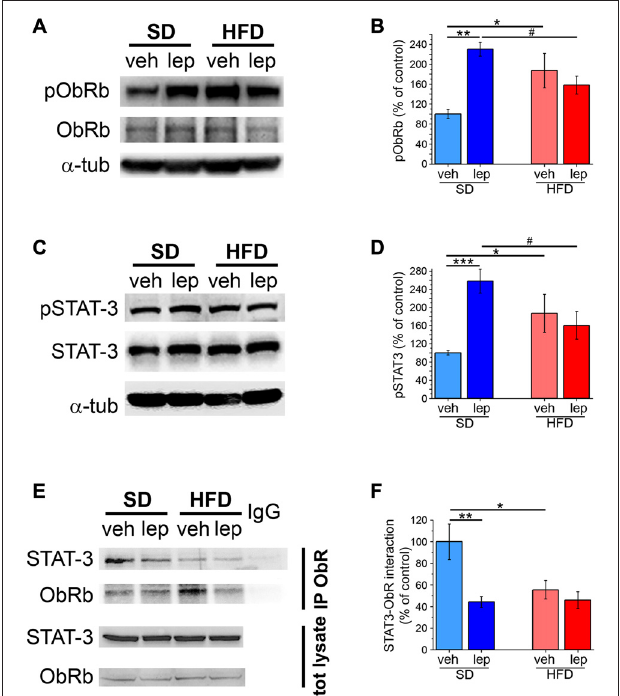
FIGURE 4 | Activation of ObRb and STAT-3 is impaired in HFD mice. (A) Representative images showing immunoblottings for pObRb, ObRb and α -tubulin. (B) Quantification of pObRb activation (SD-veh n = 4, SD-lep n = 4, HFD-veh n = 4, HFD-lep n = 4; ANOVA-2, diet × treatment interaction, p = 0.004, followed by Bonferroni post hoc test, SD-lep vs. SD-veh, ∗∗ p = 0.002, SD-veh vs. HFD-veh, ∗ p = 0.019, SD-lep vs. HFD-lep, # p = 0.046). (C) Representative images showing immunoblottings for pSTAT-3, STAT-3 and α -tubulin. (D) Quantification of pSTAT-3 activation (SD-veh n = 5, SD-lep n = 6, HFD-veh n = 5, HFD-lep n = 5; ANOVA-2, diet × treatment interaction, p = 0.003, followed by Bonferroni post hoc test, SD-lep vs. SD-veh, ∗∗∗ p < 0.001, SD-lep vs. HFD-lep, ∗ p = 0.019; SD-veh vs. HFD-veh, # p = 0.029). (E) Representative images showing immunoblottings for STAT-3 after immunoprecipitation using an anti-ObRb antibody and for the total protein lysates. (F) Quantification of STAT-3-ObRb interaction from immunoprecipitates (SD-veh n = 5, SD-lep n = 5, HFD-veh n = 4, HFD-lep n = 6; ANOVA-2, diet × treatment interaction, p = 0.043, followed by Bonferroni post hoc test, SD-lep vs. SD-veh, ∗∗ p = 0.002; SD-veh vs. HFD-veh, ∗ p = 0.011).